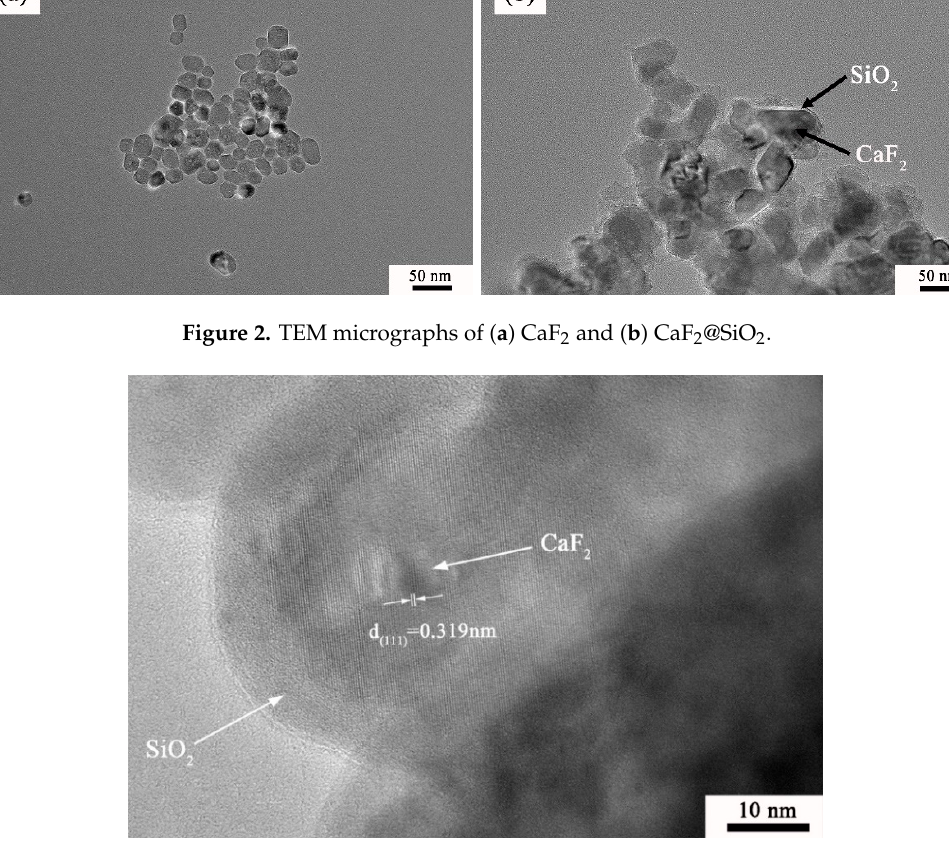
Figure 3. HRTEM micrographs of CaF 2 @SiO 2 .